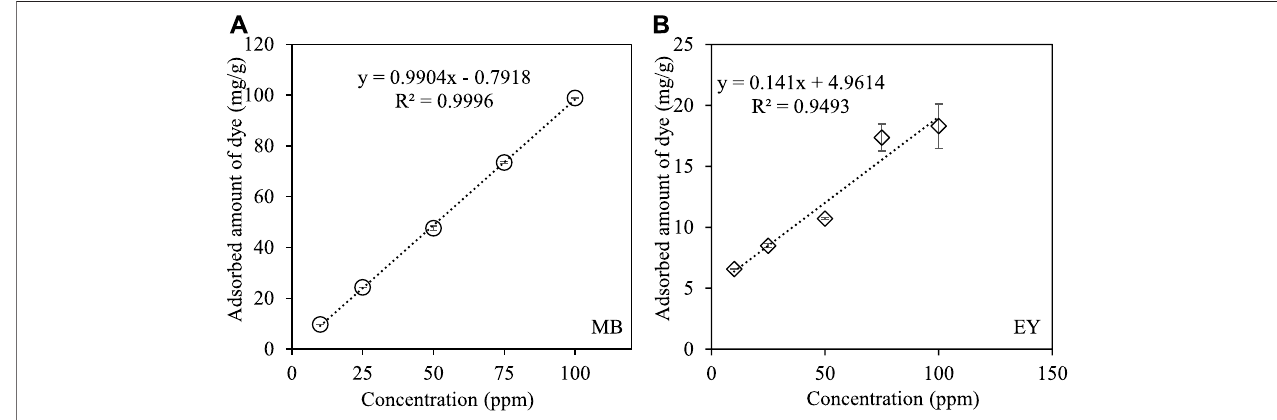
TABLE 1 | The pseudo- fi rst and pseudo-second-order kinetic constants and their respective correlation coef fi cients for the adsorption of MB and EY by HCl-treated p (APTMACl-co-AMPS)-3 hydrogels. Dye Exp.